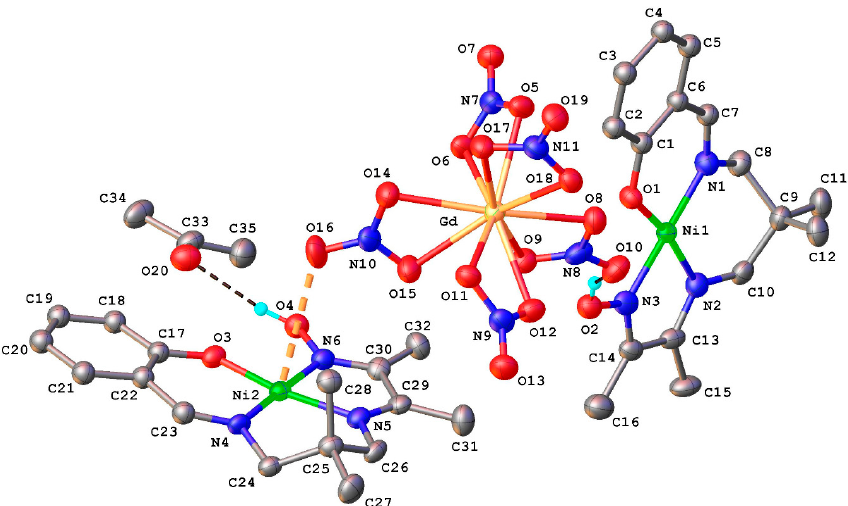
Figure 6. Molecular plot for complex 6 , along with selected bond lengths and angles. Hydrogen atoms are omitted for clarity, except those of the two protonated oxime functions. Selected bond lengths (Å) and angles ( ◦ ): Ni1–O1 1.828(3), Ni1–N1 1.865(4), Ni1–N2 1.886(4), Ni1–N3 1.871(4), N3–O2 1.390(5),